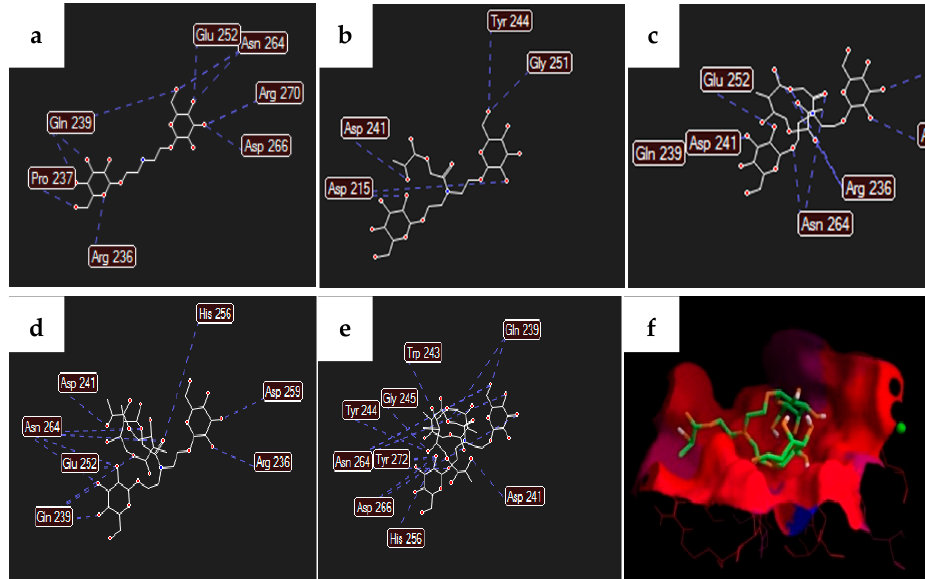
Figure 2. Hydrogen bonds between ASGP-R and ligands ( a ) 3a , ( b ) 3b , ( c ) 3c , ( d ) 3d , and ( e ) 3e ; ( f ) binding site electrostatic distribution surface with the carbohydrate recognition domain of the H1 subunit of ASGP-R including ligand 3b in the pocket. Table 1. Binding energies obtained from docking studies.